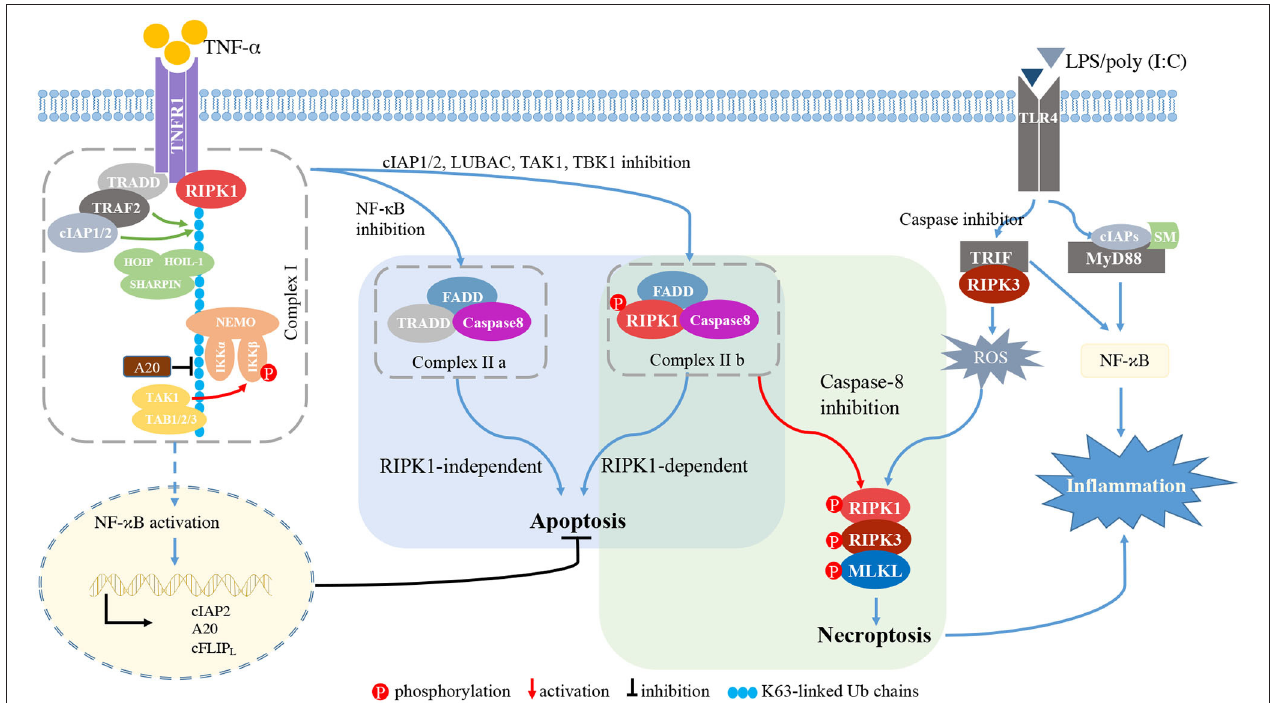
FIGURE 2 | RIPK signaling. TNFR1 recruits RIPK1, TRADD, TRAF2, and cIAP1/2. cIAP1/2 initiates the ubiquitination process on complex I. The K63 Ub chain of RIPK1 links molecules in the large TNF complex I. The TAK1 complex phosphorylates IKK β to induce NF- κ B activation. When NF- κ B, the complex of cIAP1/2, or LUBAC, TAK1, or TBK1 is inhibited, membrane-bound complex I is dissociated and complex II is formed. If NF- κ B is inhibited, TRADD, FADD and caspase-8 form complex IIa, inducing RIPK1-independent apoptosis. When inhibition of cIAP1/2, TAK1, TBK1, or LUBAC occurs, RIPK1, FADD, caspase-8, and c-FLIPL form complex IIb, inducing RIPK1-dependent apoptosis. Procaspase-8/cFLIPL heterodimers prevent necroptosis. Upon caspase-8 inhibition, complex IIb initiates RIPK1- and RIPK3-dependent necroptosis. Activated RIPK1 heterodimerizes with RIPK3 and RIPK3 phosphorylates MLKL, thereby driving the polymerization of RIPK1, RIPK3 and MLKL. This RIPK1-RIPK3-MLKL complex is called a “necrosome.” In macrophages/microglia, LPS or poly(I:C) is recognized by TLR4 and mediates the interaction between TRIF and RIPK3. In the presence of caspase inhibitor, the TRIF/RIPK3 complex induces ROS accumulation, and subsequently triggers necroptosis independent of NF- κ B activation. TLR4 also recruits MyD88 and cIAPs to activate the NF- κ B pathway, thereby inducing pro-inflammatory cytokines. TNF- α , tumor necrosis factor- α ; TNFR1, TNF α receptor 1; RIPK1/3, receptor-interacting protein kinases 1/3; TRADD, TNFR1-associated death domain protein; TRAF2, TNF receptor associated factor 2; cIAP1/2, cellular inhibitor of apoptosis 1/2; HOIL-1, haem-oxidized iron-regulatory protein 2 ubiquitin ligase-1; HOIP, HOIL-1 interacting protein; SHARPIN, SHANK-associated RH domain-interacting protein; NF- κ B, nuclear factor- κ B; NEMO, cell death-protective nuclear factor- κ B essential modulator; IKK α / β , inhibitor of NF- κ B kinase α / β ; TAB2/3, TAK1-binding protein 2 and 3; FADD, Fas associated via death domain; cFLIP L , the long isoform of cellular FLICE-like inhibitory protein; MLKL, mixed lineage kinase domain-like protein; TIRF, TIR-domain containing adapter-inducing interferon-b; MYD88,